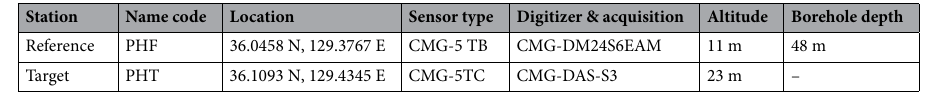
Table 1. List of seismic measuring